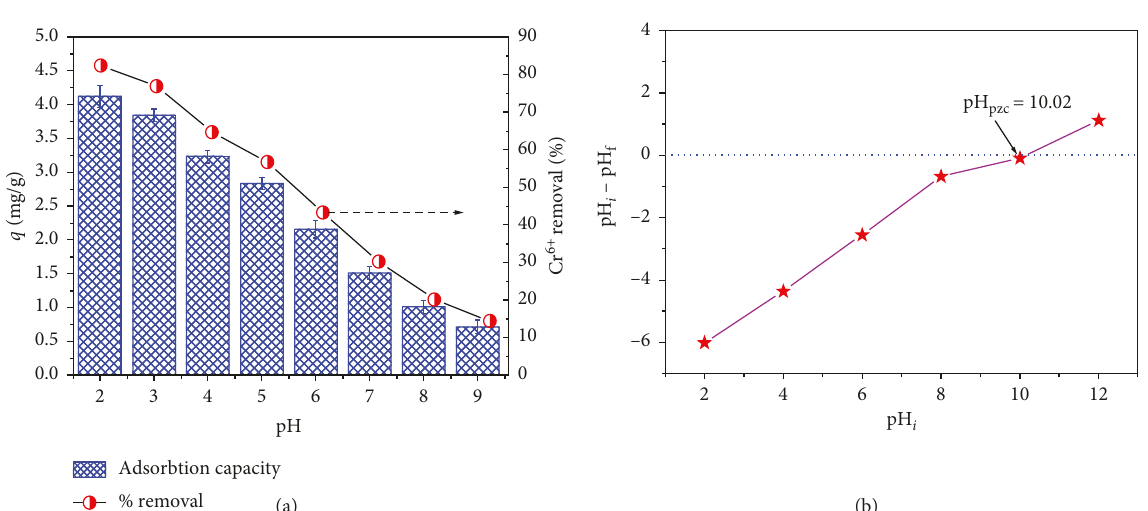
Figure 4: (a) Effect of solution pH on Cr(VI) adsorption by FSS at 10mg/L of initial Cr(VI); 4g/L of adsorbent dosage; 20 ° C; 120min of contact time; (b) pH PZC of